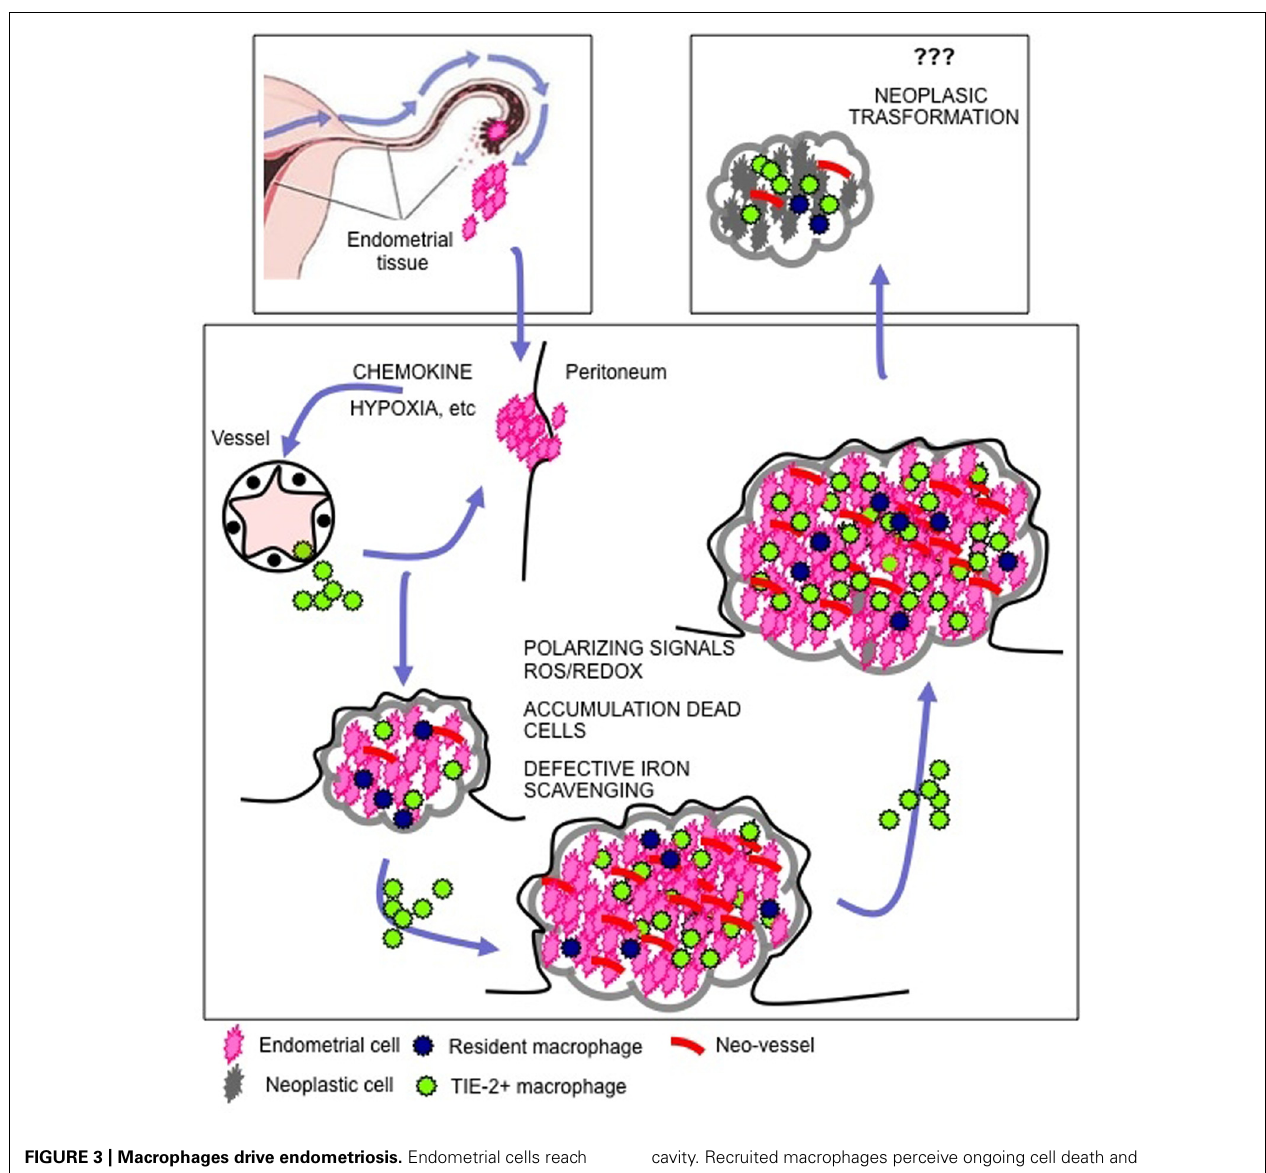
FIGURE 3 | Macrophages drive endometriosis. Endometrial cells reach the peritoneal cavity as a consequence of retrograde menstruation.The recruitment of macrophages at the site of endometrial cell engraftment is a limiting step for the lesion to organize and to growth. Local hypoxia and the production of chemokines play a major role in the recruitment of macrophages. Once endometriosis is established, the cyclic death of endometrial cells as a consequence of progesterone withdrawal leads to the release of cell debris, erythrocytes, and heme-bound iron in the peritoneal